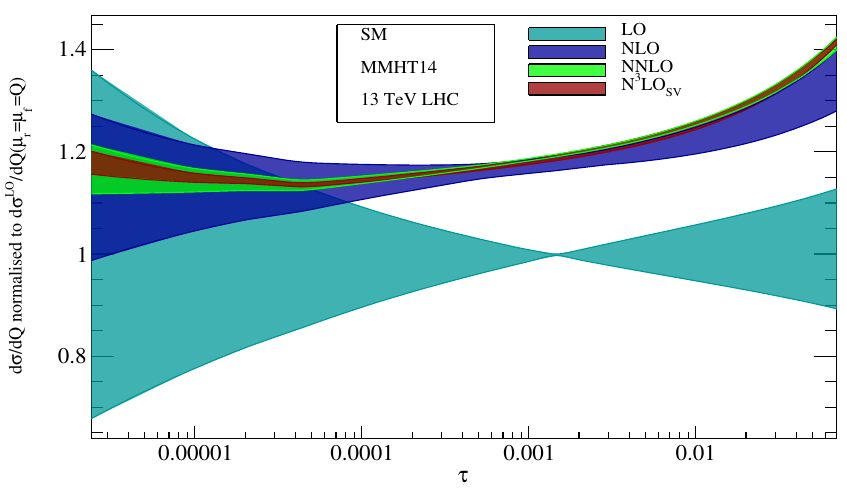
Figure 2 . 7-point scale variation is plotted against the hadronic (cid:28) variable up to N 3 LO sv order. All the (cid:12)gures are normalized to LO contribution evaluated at the central scale (cid:22) r = (cid:22) f = Q